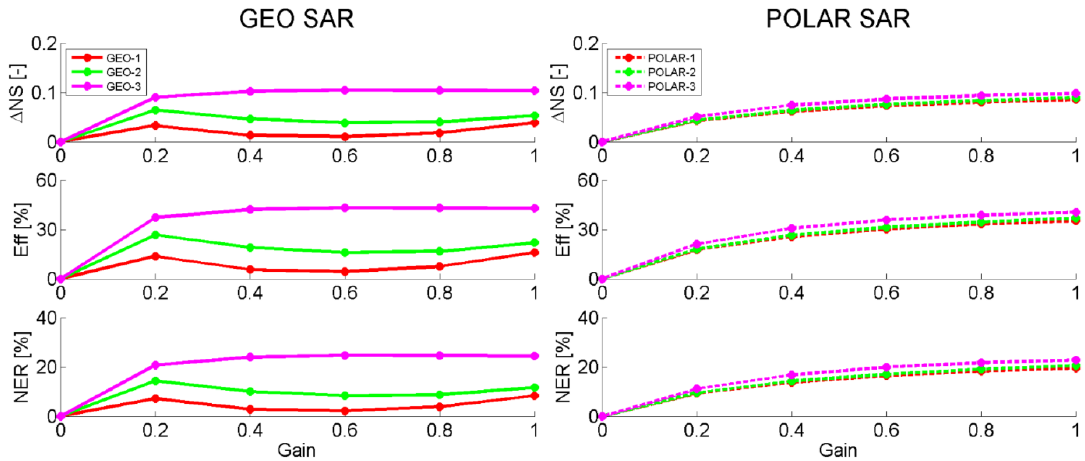
Figure 8. Synthetic experiment: impact on model discharge predictions after SM-DA of GEO SAR (left column) and POLAR SAR (right column) products. OL values (i.e., gain equal to zero) in term of NS and RMSE are, respectively, 0.76 [-] and 18 [m 3 s − 1 ].